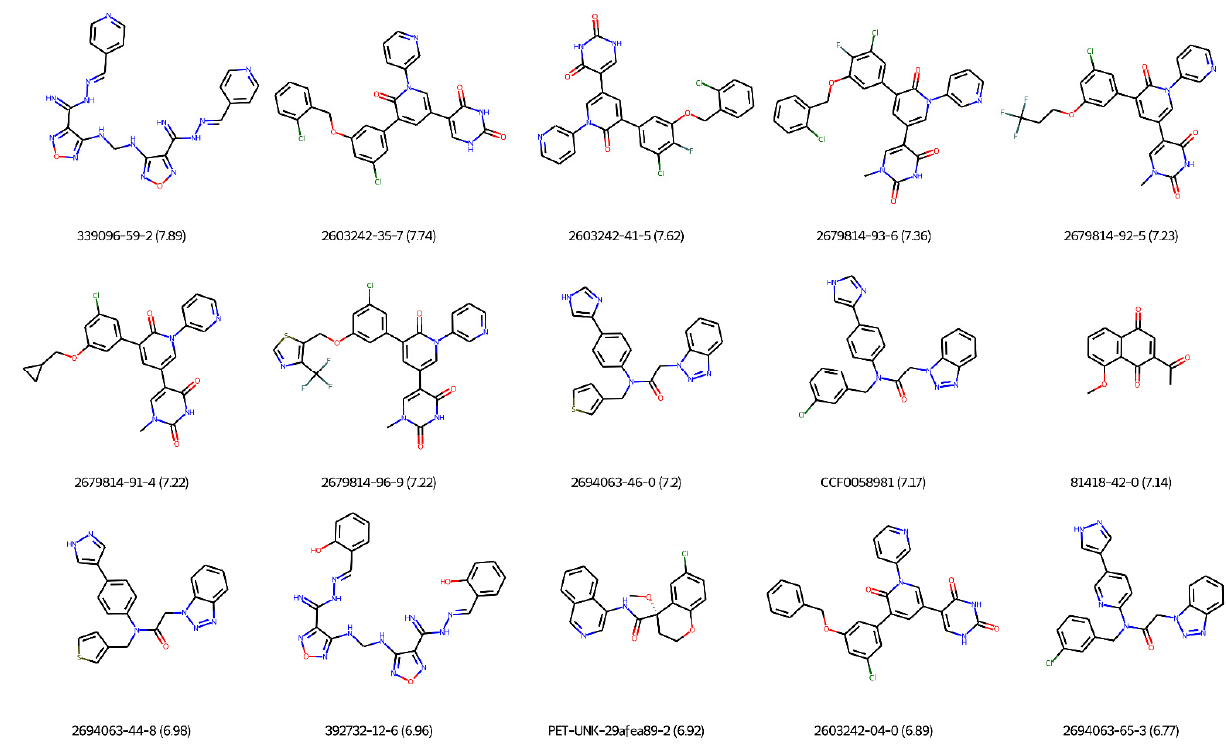
Figure 7. The 15 most potent non-covalent inhibitors of the SARS-CoV-2 M-pro. Only M-pro inhibitors with pIC 50 values that can inhibit SARS-CoV-2 replication in a cellular antiviral assay are shown. pIC 50 values are shown in parentheses.